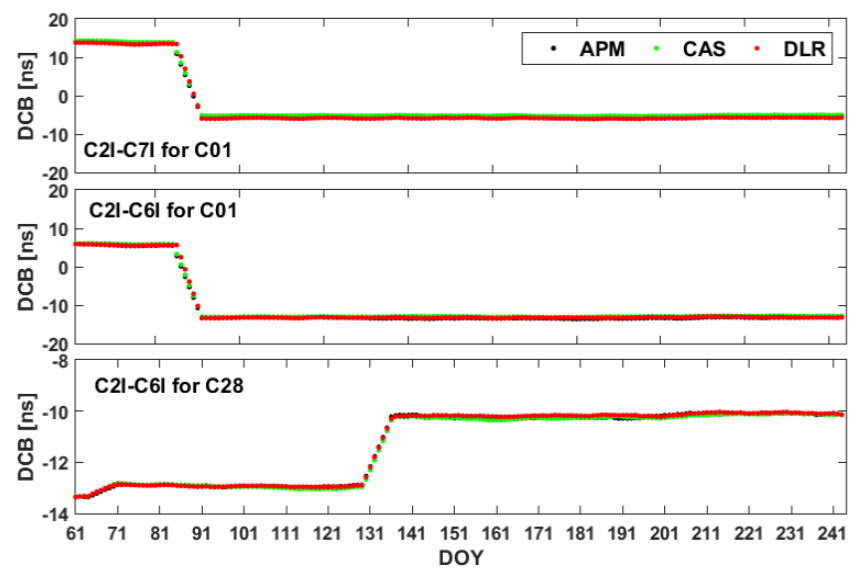
Figure 3. Time series of weekly mean differential code biases (DCB) of the selected satellites during the period of day of year (DOY) 061–244 in 2020.